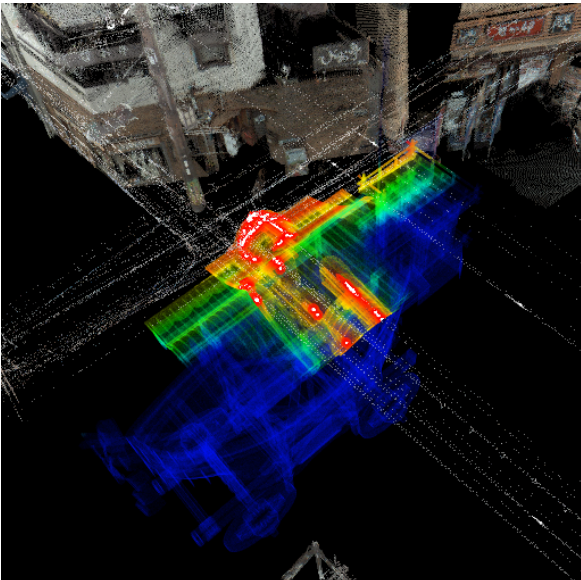
Figure 9. See-through visualization of the Ofune-hoko float that collides with electric wires. The total number of points used for the visualization is 8 . 4 × 10 ! , and the rendering speed is 16.19